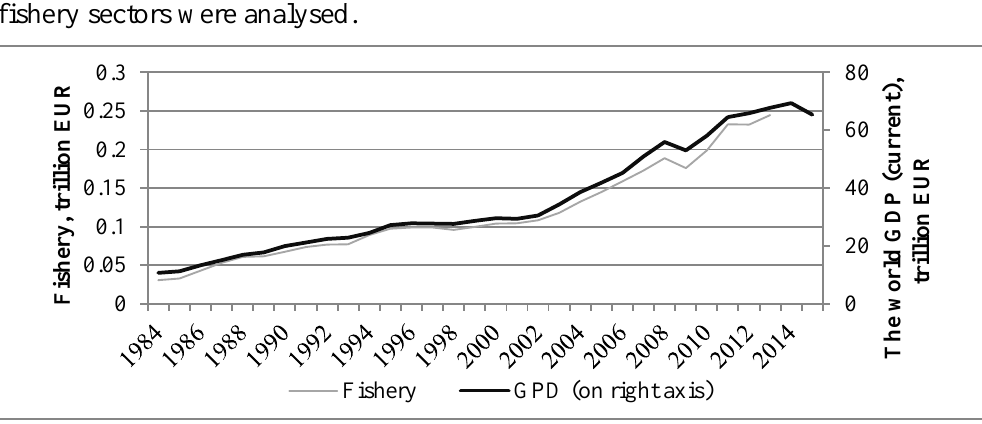
Fig. 1. World GDP from 1984−2015 and fishery trade and production from 1984−2013), (Developed by author; World Bank (GDP) data, 2016; FAO data,